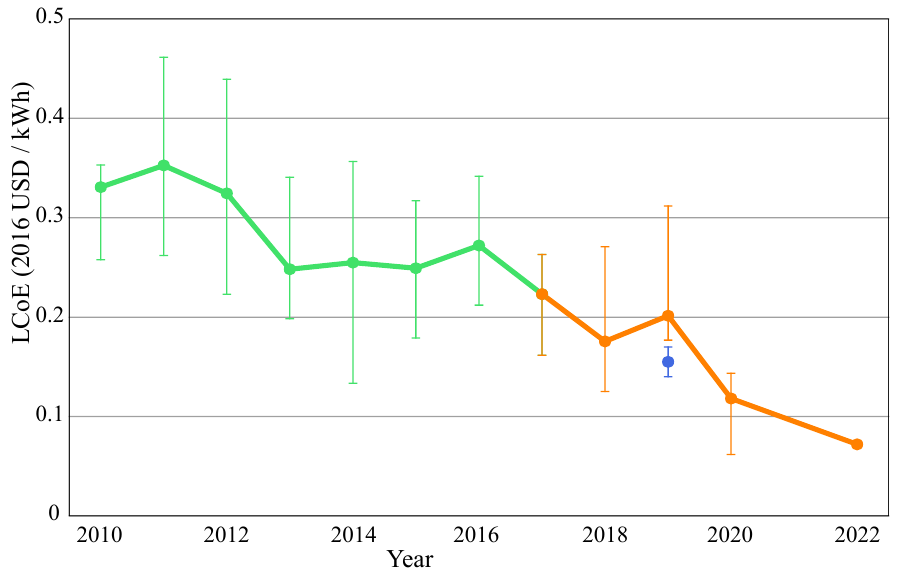
Figure 16. Levelized cost of electricity and auction price trend for CSP in the period 2010–2022. The figure is taken from International Renewable Energy Agency (IRENA) [49]. The blue line showing the tendency corresponds to actual data and the orange one to estimations. Error bars are estimated by considering different locations. The LCoE estimated for the solar Brayton dish in this work is displayed in blue.